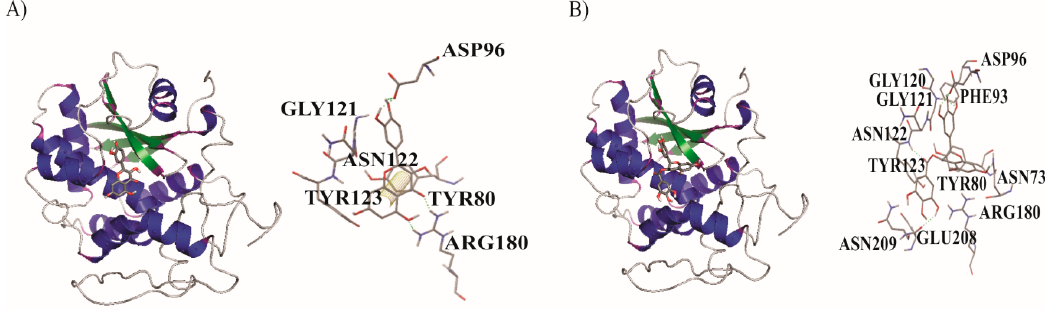
Figure 6. Detailed molecular interactions of ( A ) quercetin (Q) and ( B ) epigallocatechin gallate (EGCG) both with the active site of the A chain of the protein ricin.